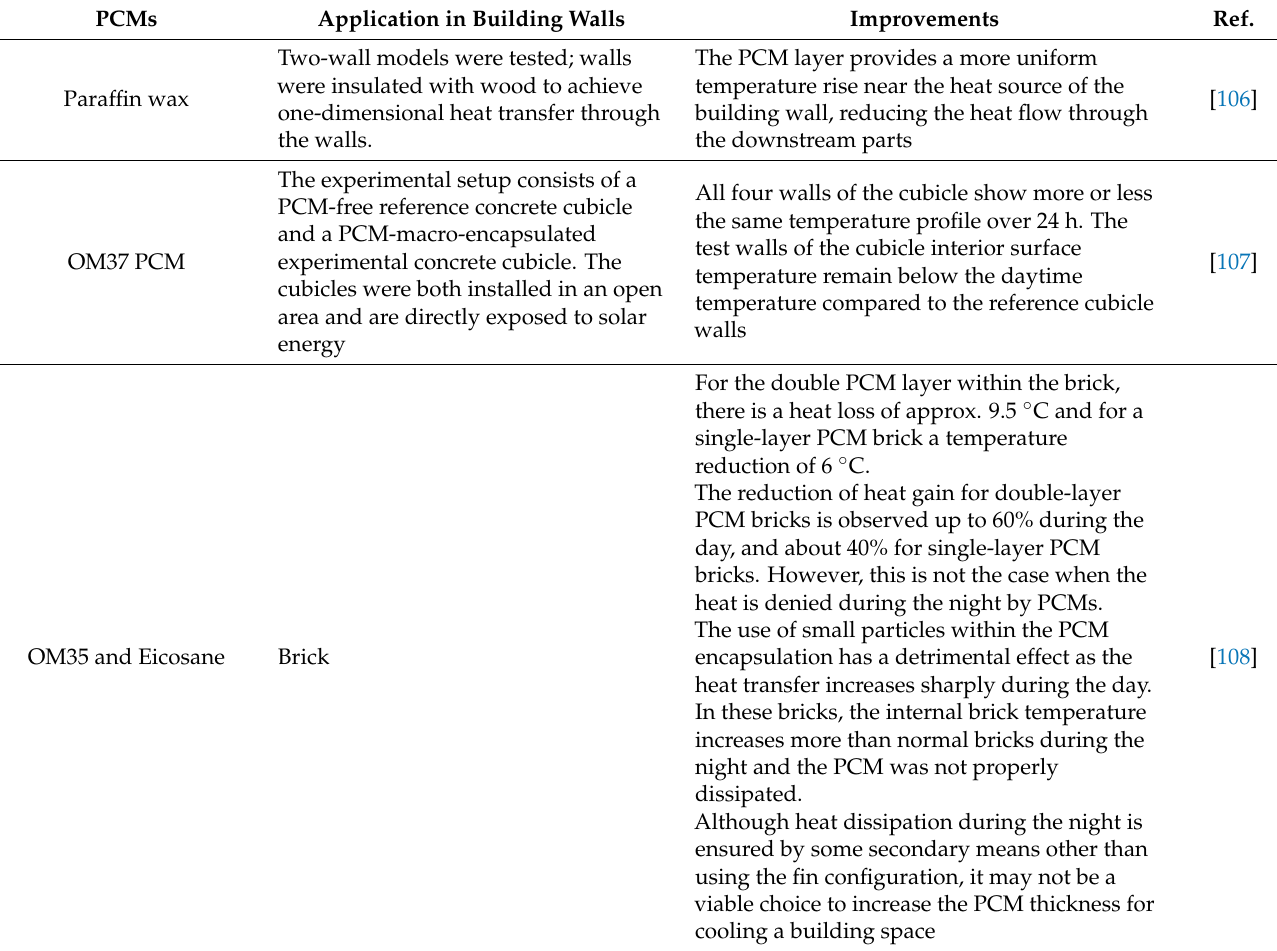
Table 7. Summary of different experimental studies in 2020 from the literature on wall applications. PCMs Application in Building Walls